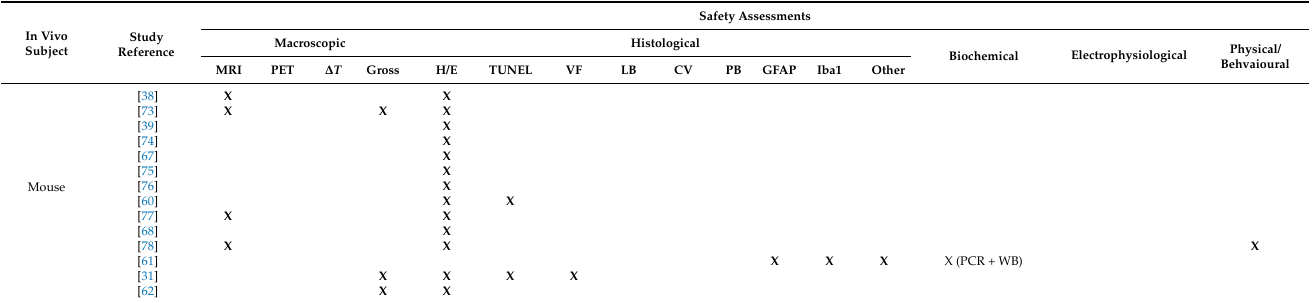
Table 2. Summary of safety assessments conducted by included